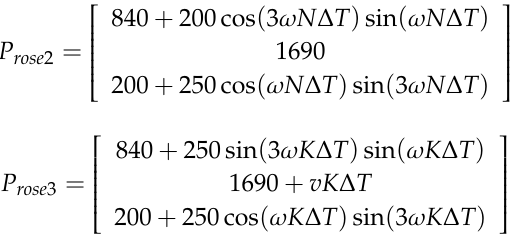
Figure 15. Joint velocities of the improved PHUVS with the KF-SVSF method in the static positioning experiment.